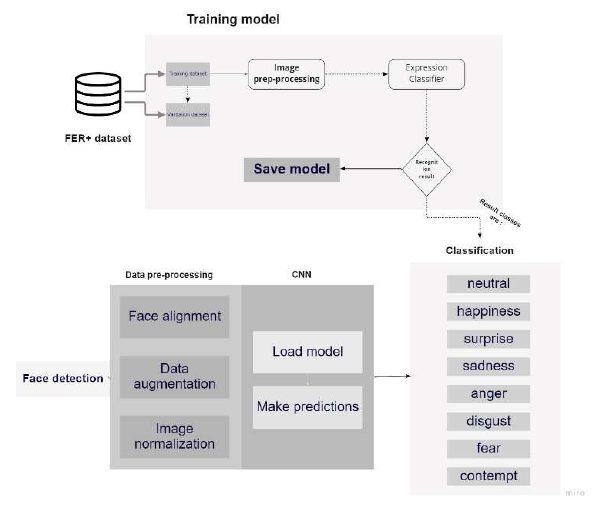
Figure 4. Process description